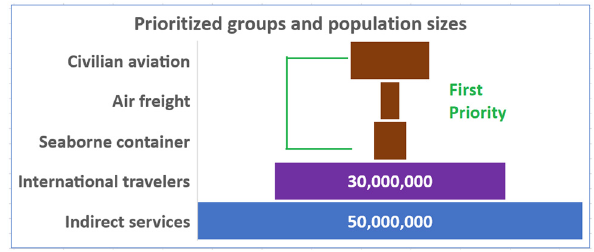
Figure 1: Prioritized groups and their population sizes for